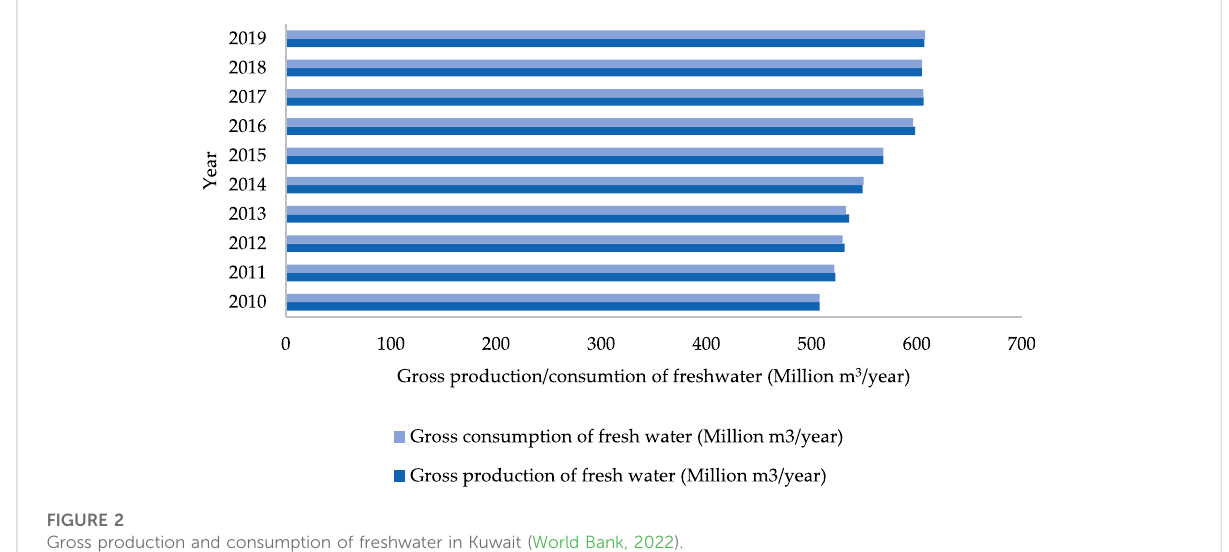
FIGURE 2 Gross production and consumption of freshwater in Kuwait (World Bank, 2022).